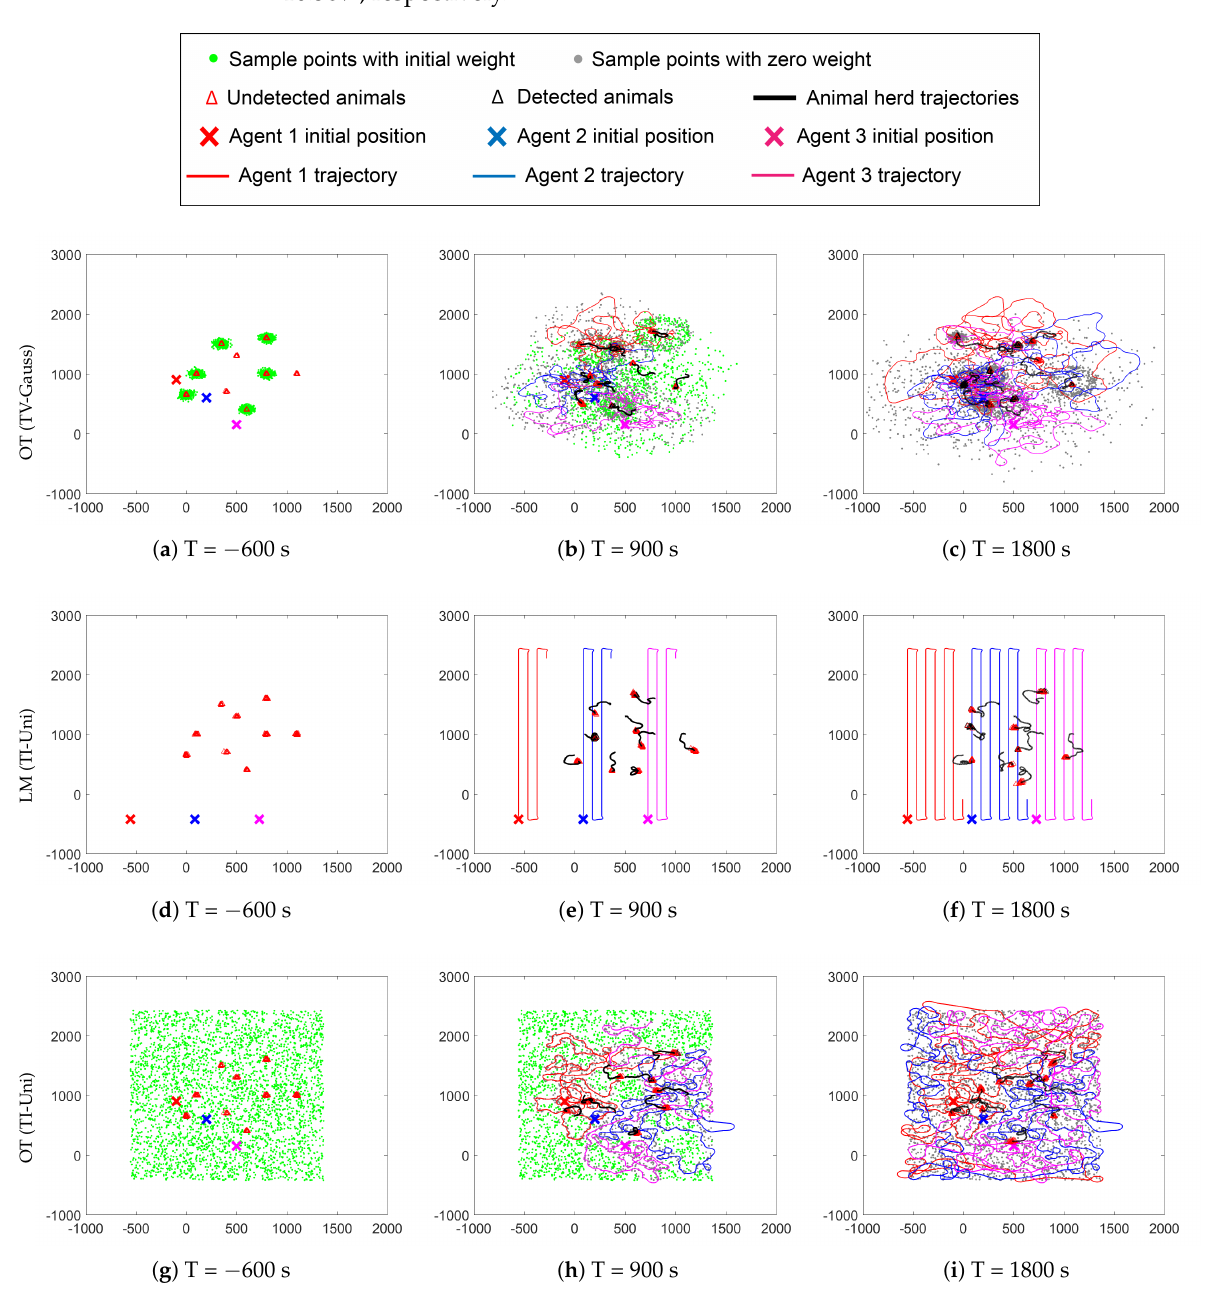
Figure 8. Snapshots of different monitoring strategies when the exploration time is given by 1800 s: ( a – c ) OT (TV-Gauss); ( d – f ) LM (TI-Uni); ( g – i ) OT (TI-Uni). The negative time indicates the time to travel from the base station to the pre-specified location before the initiation of the monitoring mission. The monitoring mission starts at T = 1 s and continues until 1800